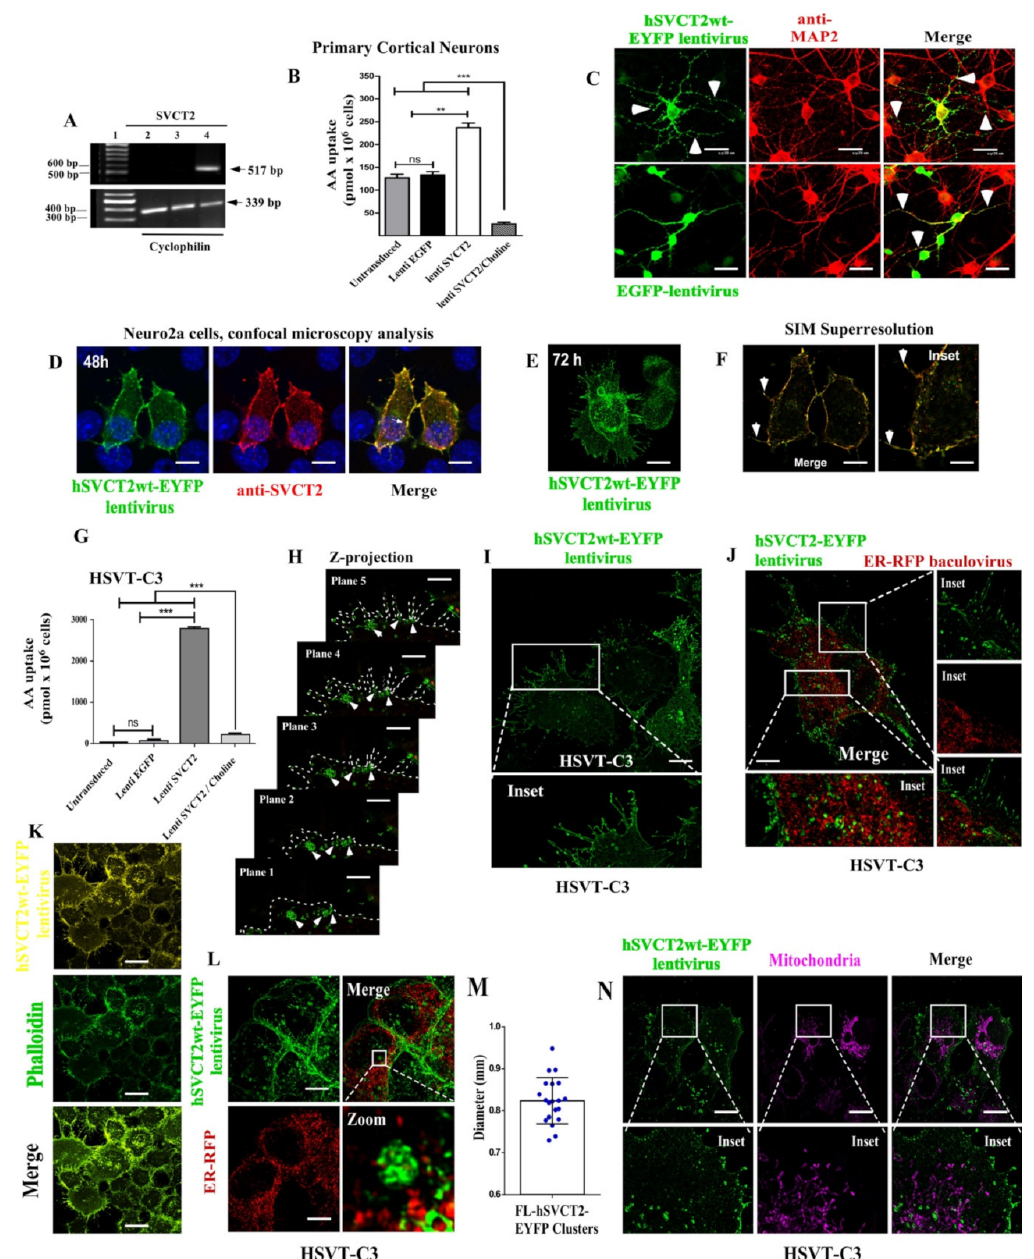
(Figure 1A, lane 4). In contrast, no hSVCT2wt-EYFP mRNA expression was detected in the non-transduced cultures (Figure 1A, lane 2) or EFGP-transduced neurons (Figure 1A, lane 3). [ 14 C]-AA uptake analysis demonstrated the functionality of the expressed transporter as the cultures of neurons transduced with hSVCT2wt-EYFP lentivirus captured twice the amount of AA (236.74 ± 20.58 pmol × 10 6 cells) as compared to nontransduced neurons (127.13 ± 13.75 pmol × 10 6 cells) or those transduced with the EGFP lentivirus (133.58 ± 11.80 pmol × 10 6 cells) (Figure 1B).